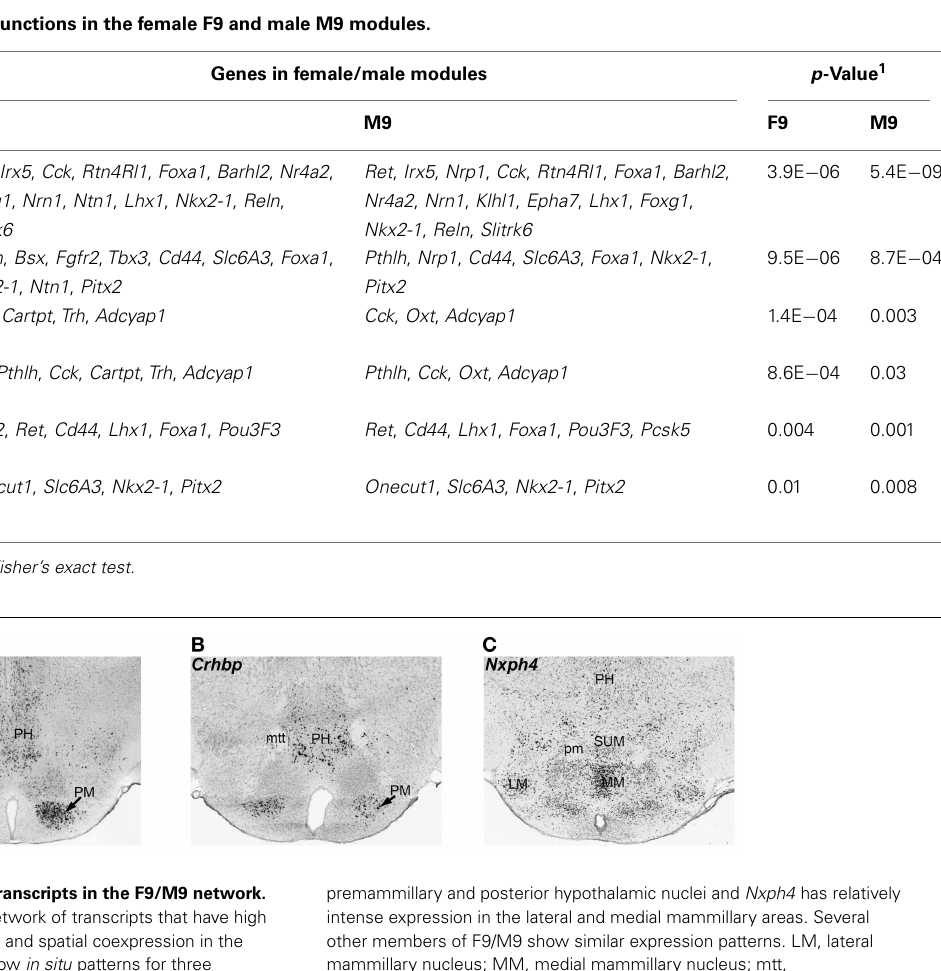
FIGURE 6 | Spatial coexpression of transcripts in the F9/M9 network. The F9 and M9 modules represent a network of transcripts that have high genetic covariance independent of sex, and spatial coexpression in the hypothalamus.The coronal sections show in situ patterns for three members of F9 and M9: Adamts2 (A) , Crhbp (B) , and Nxph4 (C) .These transcripts have high expression in the mammillary areas and the posterior hypothalamus. Adamts2 and Crhbp have pronounced expression in the